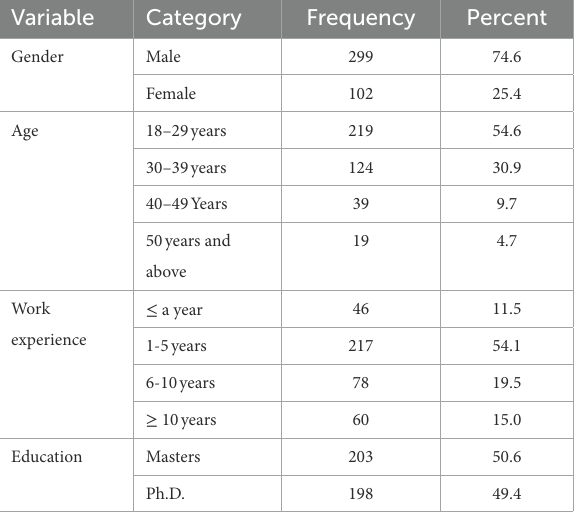
TABLE 1 Sample demographics statistics, N =